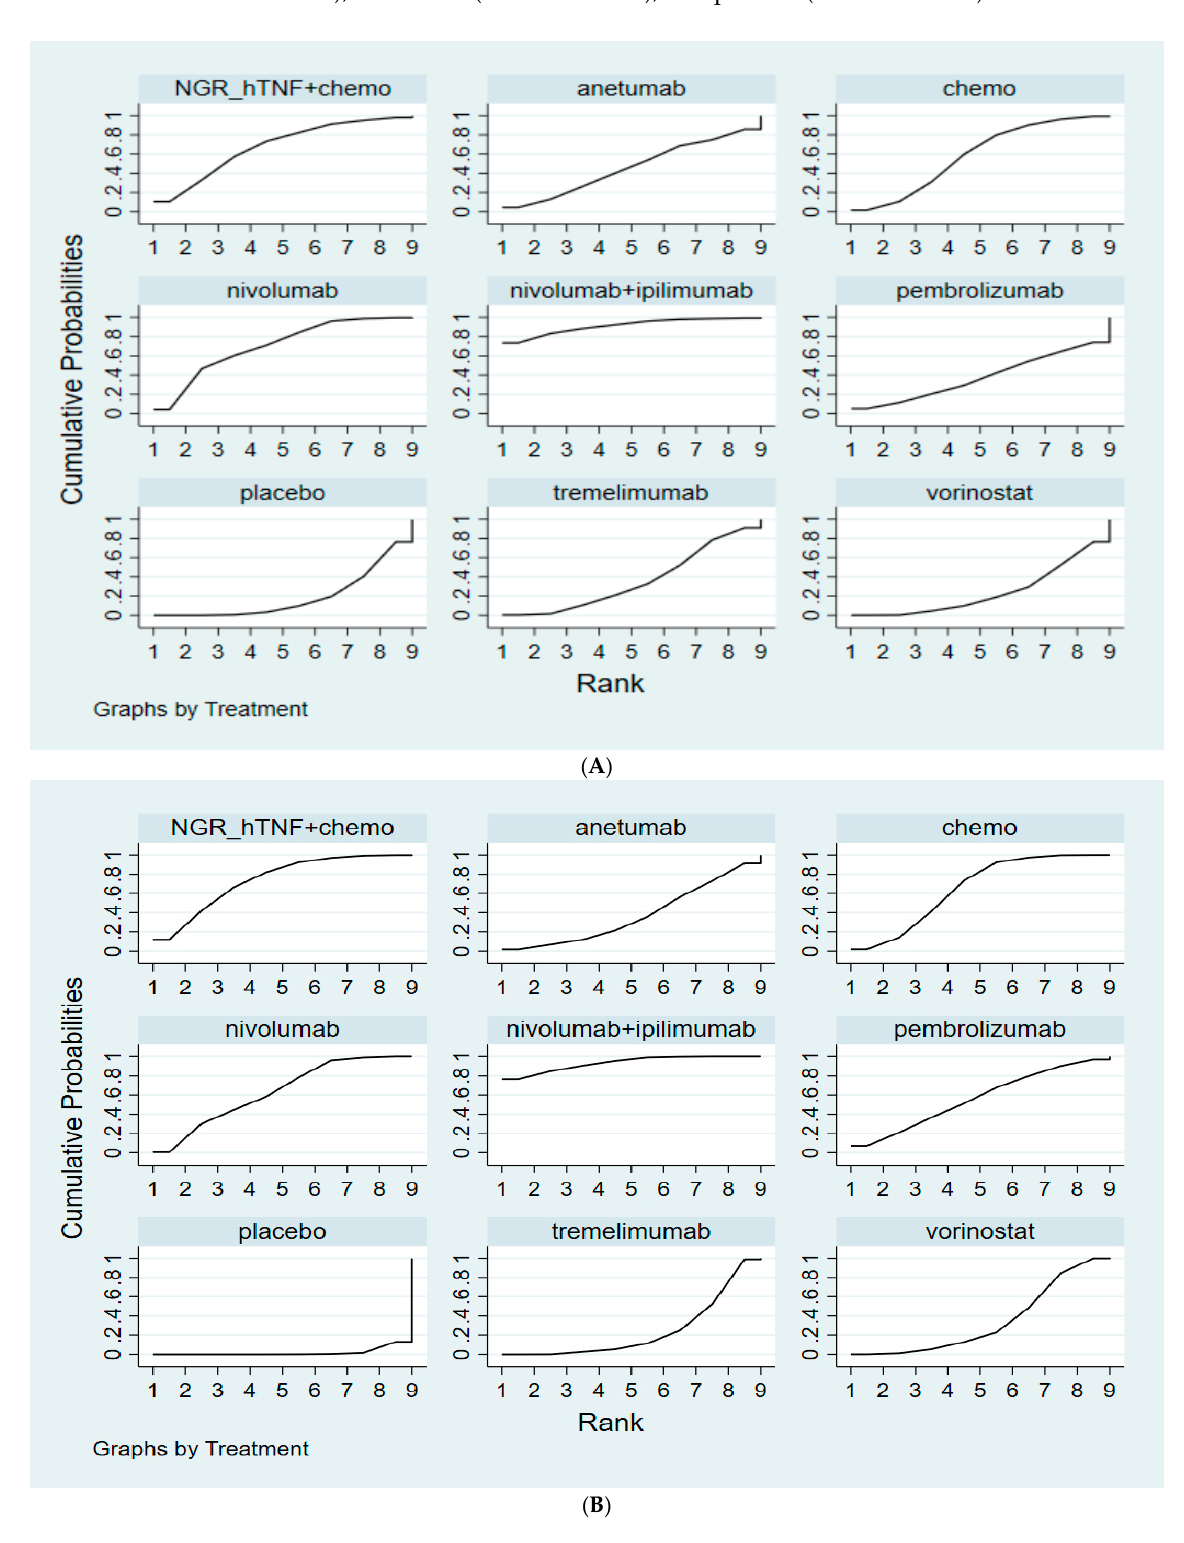
Figure 4. Cumulative ranking probability for different interventions. ( A ) Hazard ratio for overall survival (OS). ( B ) Hazard ratio for progression-free survival (PFS).